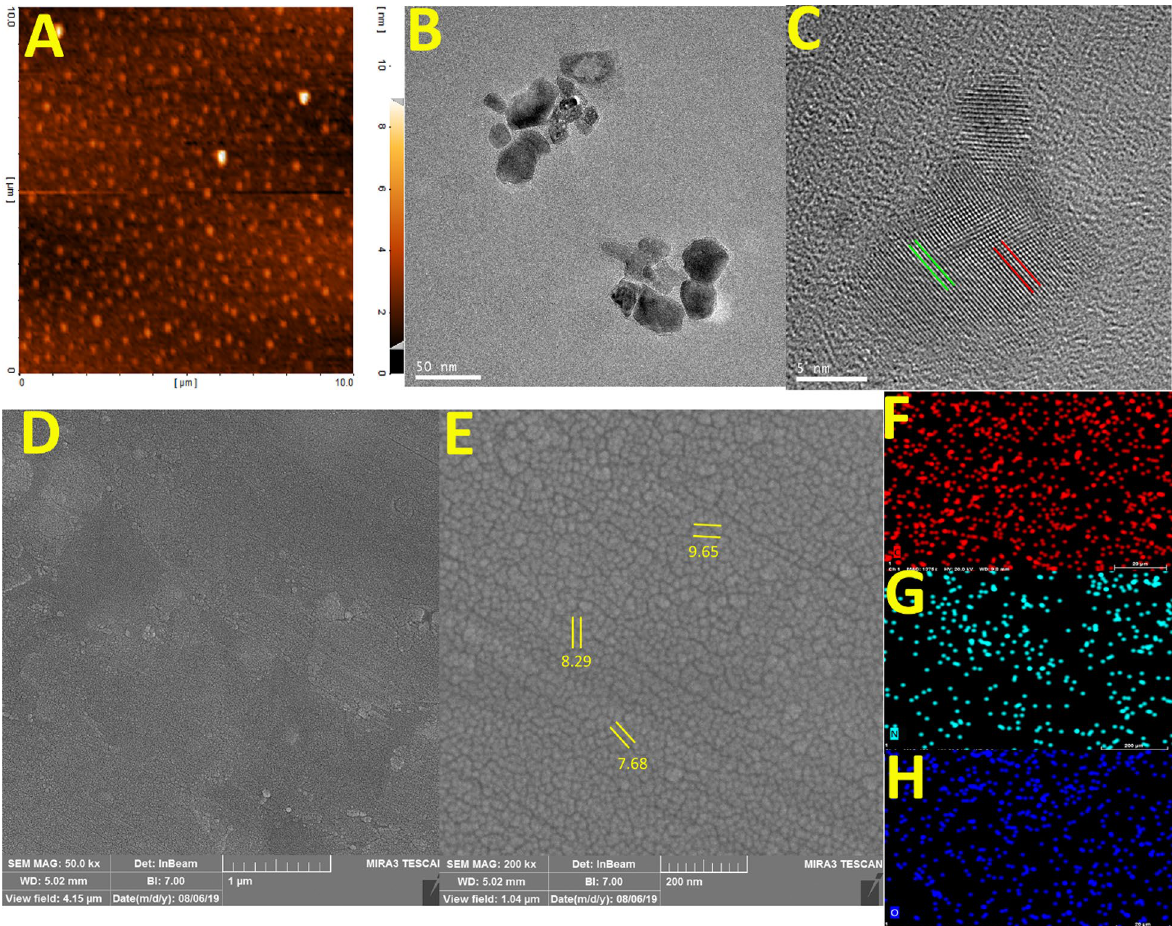
Figure 3. ( A ) The AFM image from Arginine-CQDs, ( B ) TEM image of the of Arginine-CQDs, ( C ) the 5 nm resolution TEM image of Arginine-CQDs, ( D , E ) FE-SEM images of Arginine-CQDs, ( F ) the EDX elemental mapping and distribution of C atoms, ( G ) the EDX elemental mapping and distribution of N atoms, and ( H ) the EDX elemental mapping and distribution of O